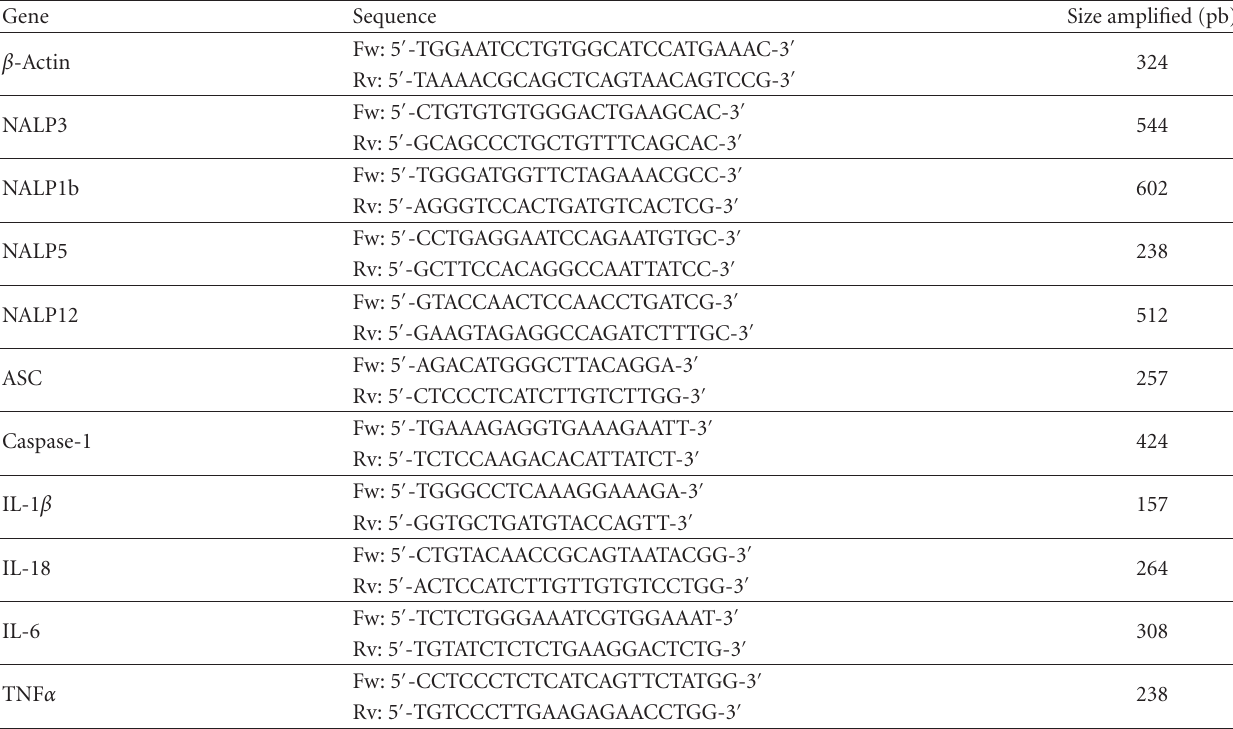
Table 1: Sequence of